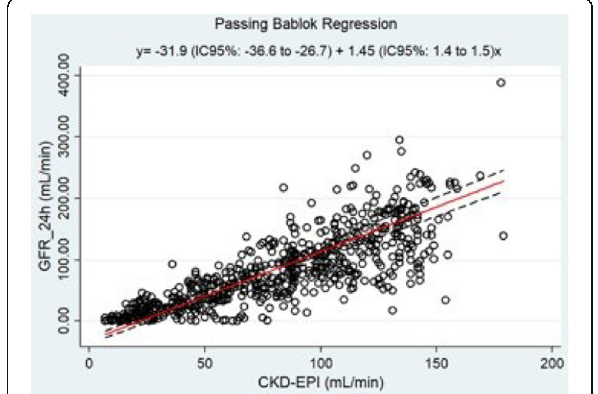
Fig. 1 (abstract 000595). See text for description